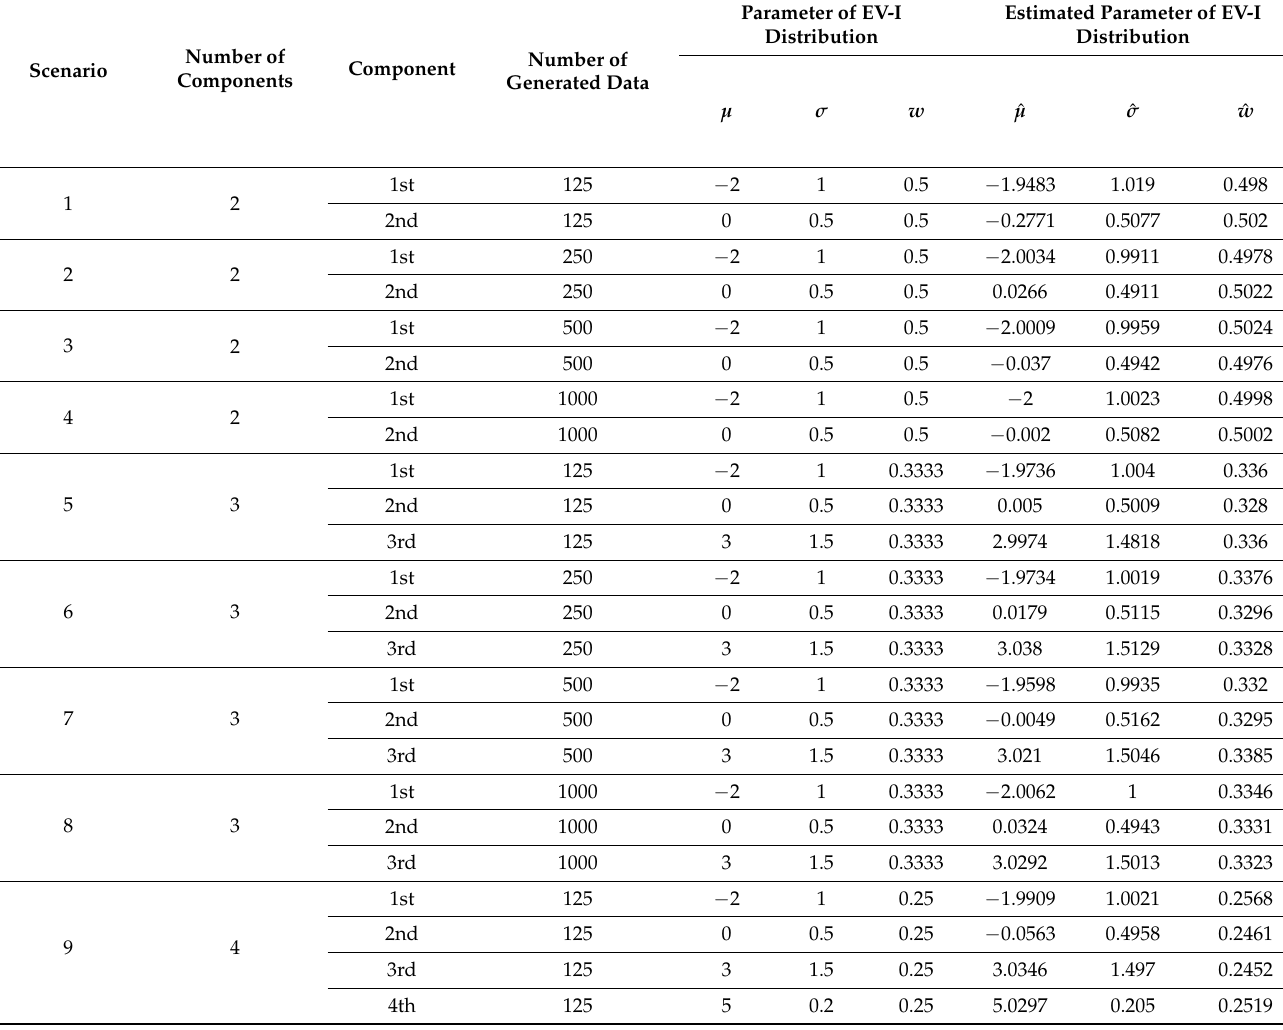
Table 3. Parameter estimation of 16 scenarios, where µ , σ , and w are the real parameters and ˆ µ , ˆ σ , and ˆ w are the estimated